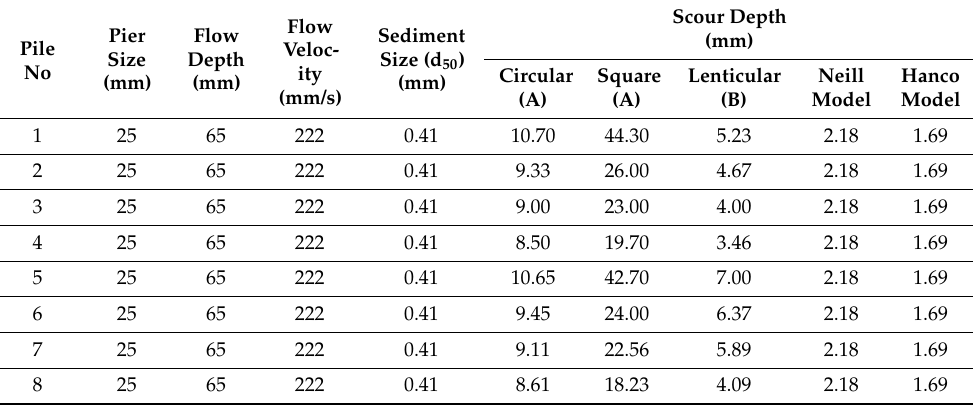
Table 3. Comparison of Scouring Depth at different Position (based on maximum sscour) with Neil and Hanco